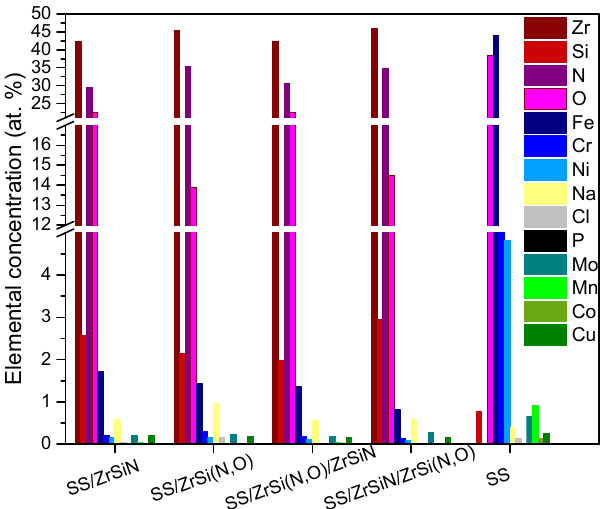
Figure 7. The elemental composition of the investigated specimens after the corrosion tests.